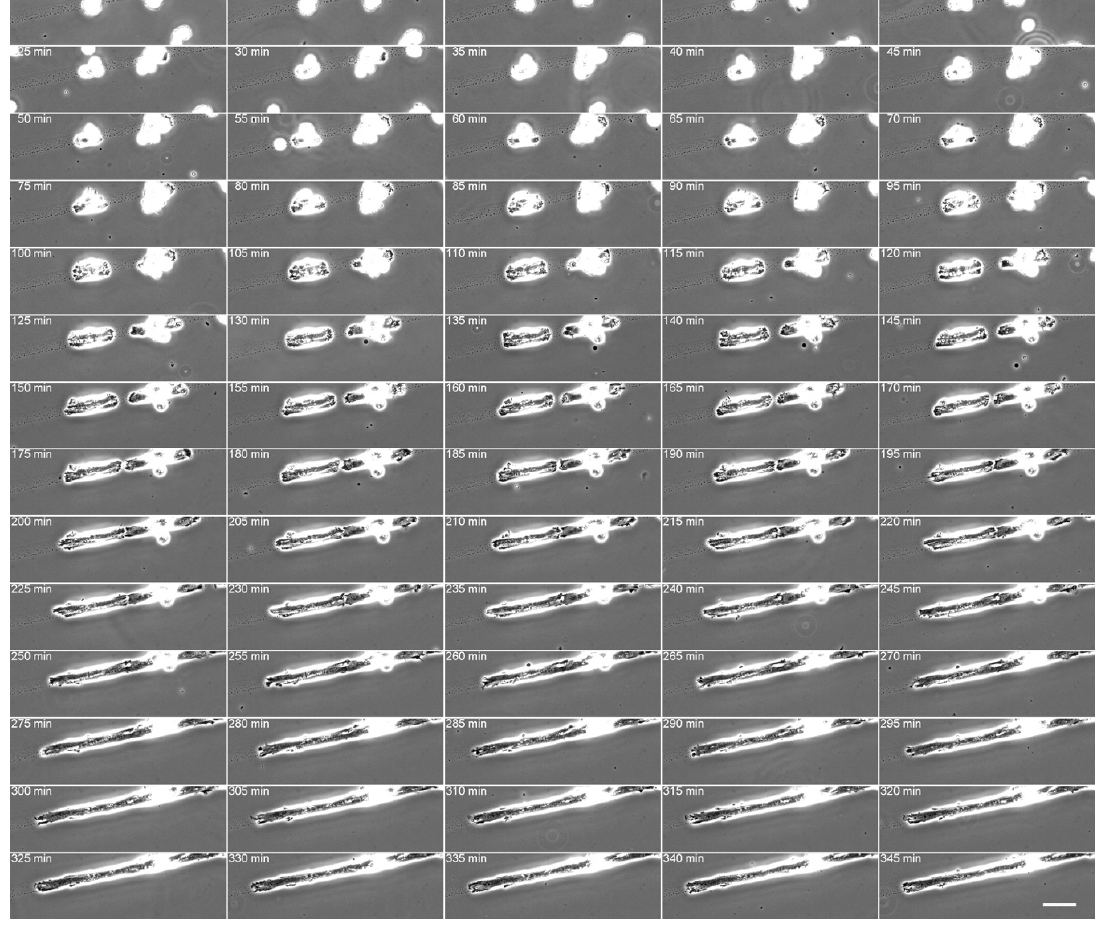
Figure 2. Time-lapse imaging of living fibroblasts adhering to adhesive micropattern (width: 10 μ m). The cells were aligned along the longitudinal axis of adhesive micropatterns within 2 h. Adherent cells were not observed on the nonadhesive region of the glass surface. The time intervals are indicated at the top left in minutes. Phase contrast microscopy. See also a supplemental movie for live imaging and Materials and Methods. Scale: 20 μ m.